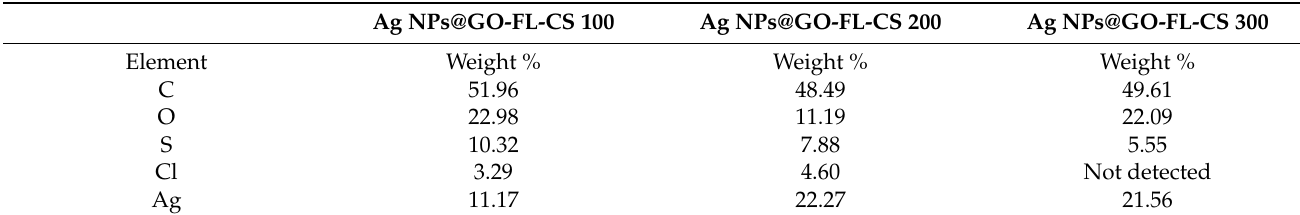
Figure 2. ( a ) SEM micrograph of Ag NPs@GO-FL-CS 100 and ( b ) the EDX analysis spectrum. Table 2. Quantitative analysis of detected element using EDS